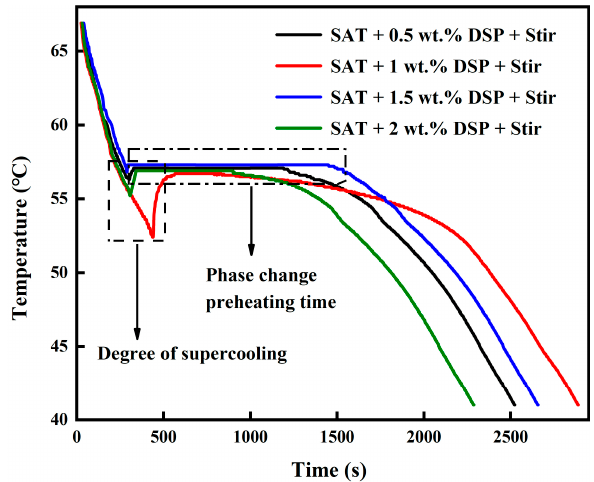
Figure 3. Supercooling curve using stirring and DSP.